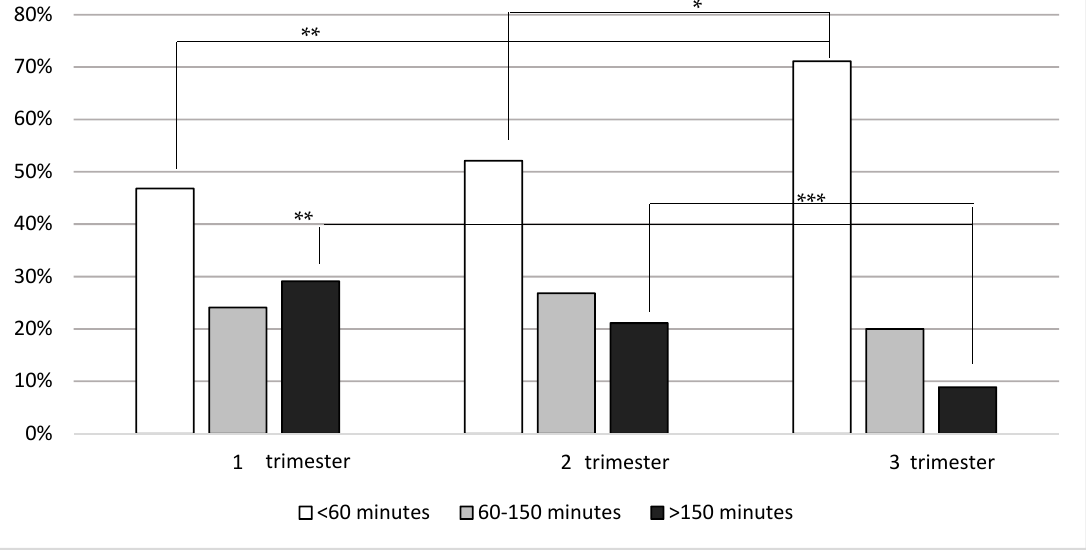
Figure 2. Declared total time of exercises per week in a group of physically active women with a twin pregnancy. * p = 0.004; ** p ≤ 0.01; *** p = 0.017.